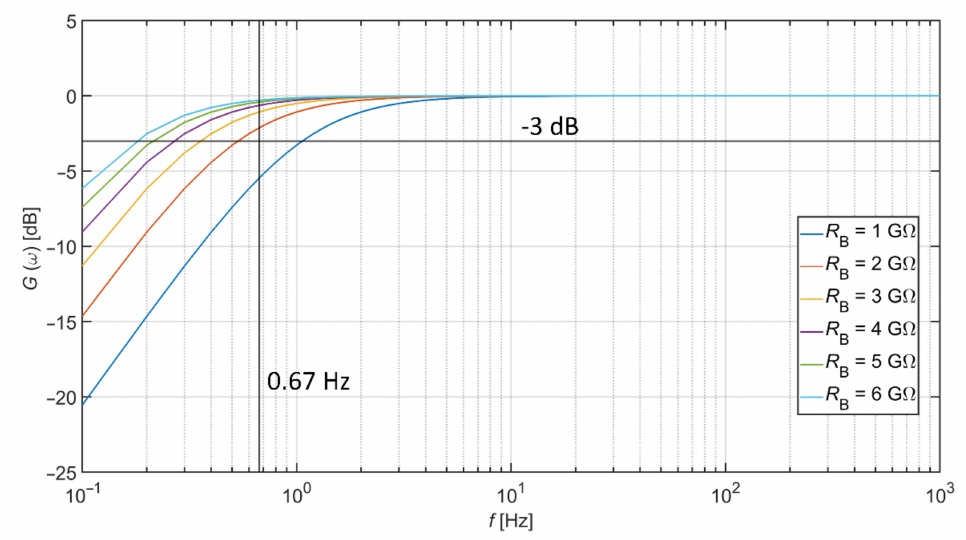
Figure 2. Transfer characteristics according to different values of R B .